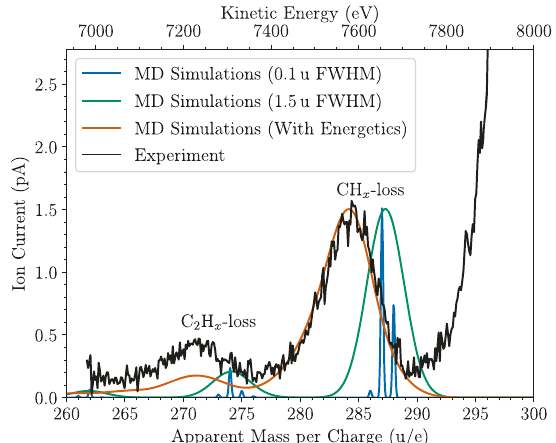
Fig. 3 Excitation energy distributions for different fragments. The values were obtained from our MD simulations of coronene molecules colliding with He atoms at a center-of-mass energy of 105 eV. The median of each distribution ( ^ E exc ) is given in the legend and indicated by an arrow in the corresponding color at the top of the fi gure. The error bars represent the 1 σ statistical uncertainties of each bin. Source data are provided as a Source Data fi